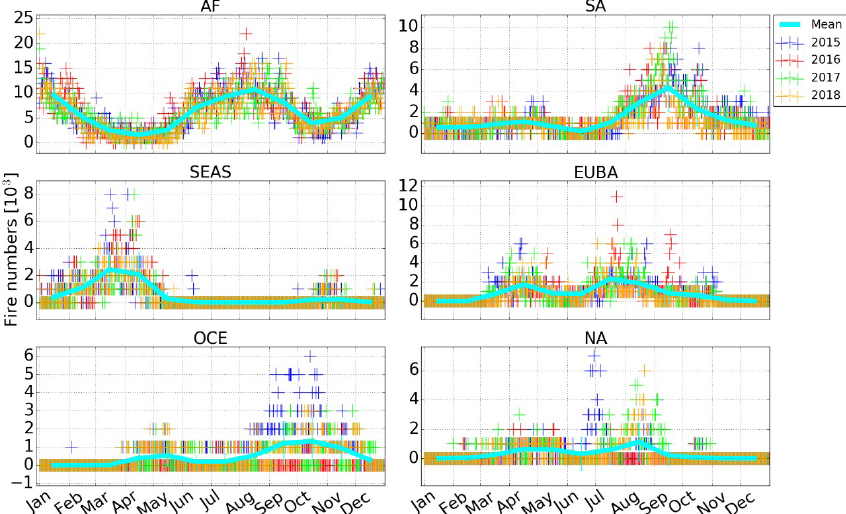
Figure 14. Seasonality of total number of fires within the AF, SA, SEAS, EUBA, OCE, and NA tracers. All data are accumulated from the FIRMS fire